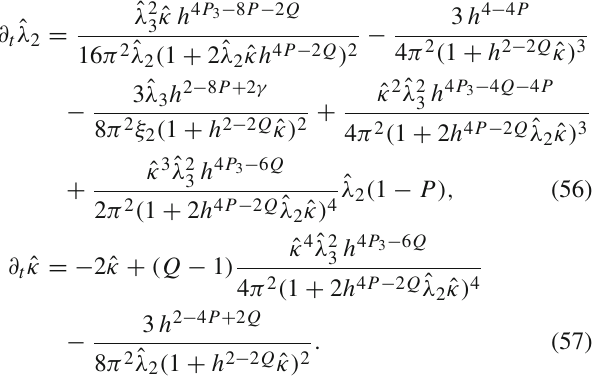
Fig. 5 Effective field theory analysis including thresholds for P = 1 / 2. We show the QFP solutions ˆ λ 3 ( ˆ λ 2 ) (left) and κ( ˆ λ 2 ) (right) for the case P 3 = 2 to leading order in the h 2 → 0 limit, as expressed in Eqs. (55) and (54). The left panel illustrates that for every ˆ λ 2 (cid:6)= − 6